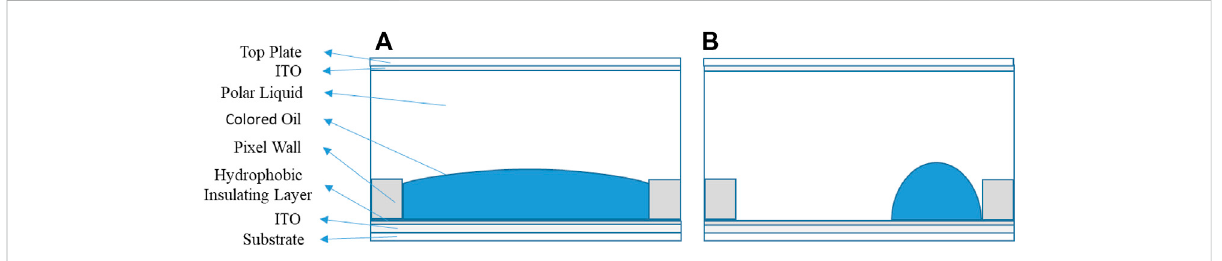
FIGURE 1 PixelstructureofaEWDpanel.Thestructureincludesatopplate,ITO, fl